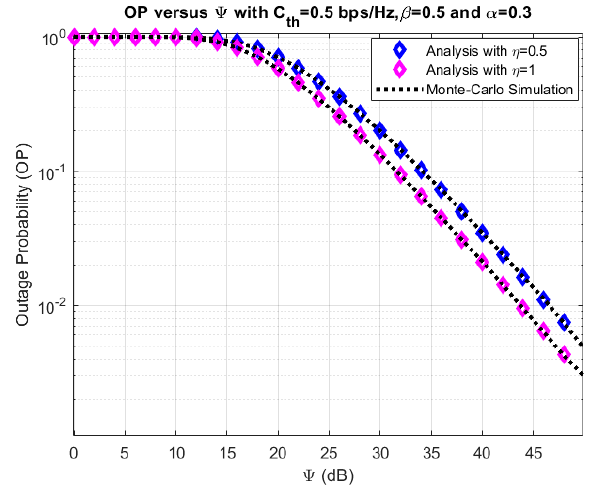
Figure 7. OP versus ψ .